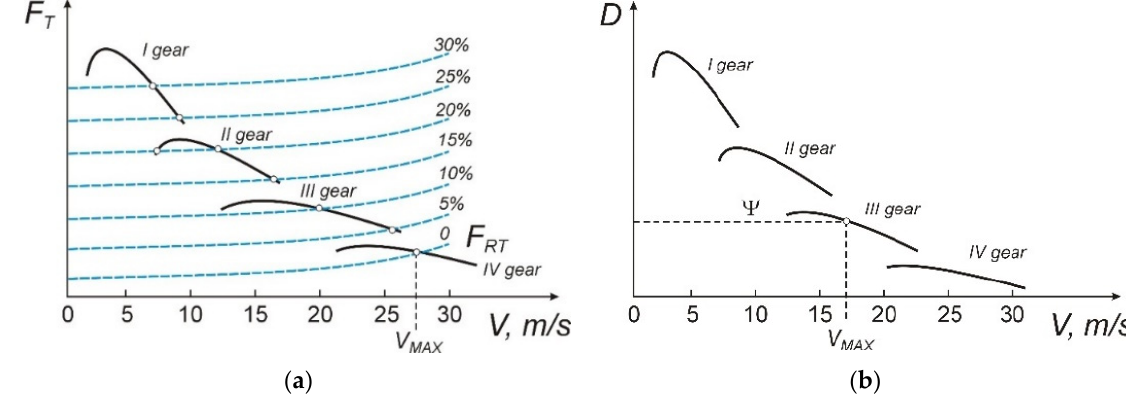
Figure 4. Examples of ( a ) the tractive effort curves—driving force as a function of speed for a car equipped with a four-speed gearbox, with the marked influence of the angle α of the road inclination on the maximum speed achieved (marked points of intersection) and ( b ) the dynamic characteristics D = f(v) of a car with the same gearbox.